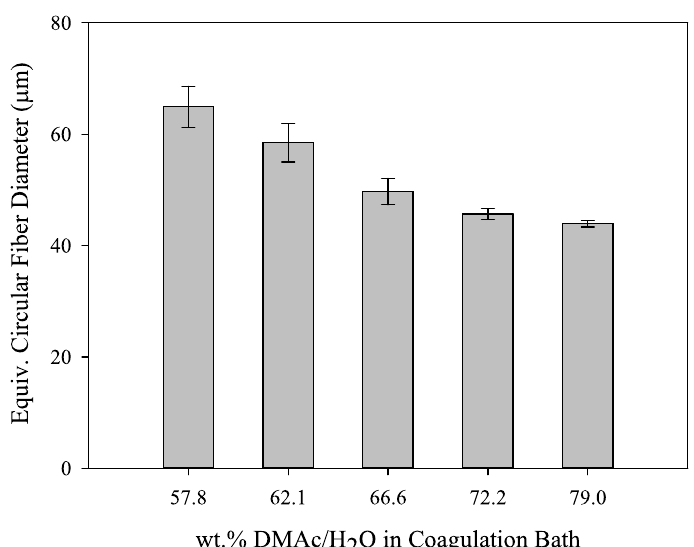
Figure 6. Equivalent circular fiber diameter for the fibers shown in Figure 5 (sampling point 1).